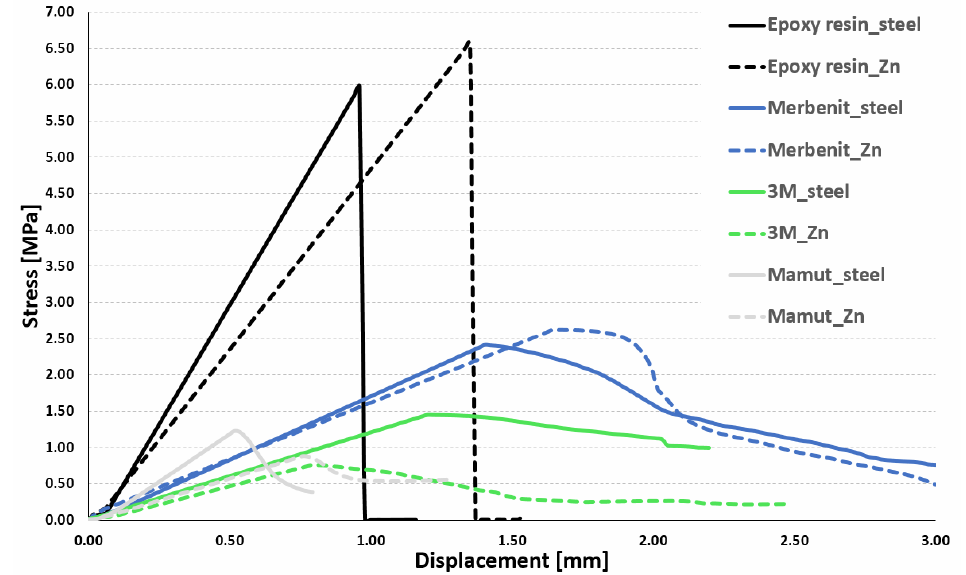
Figure 3. Addiction stress – displacement, tensile stress.